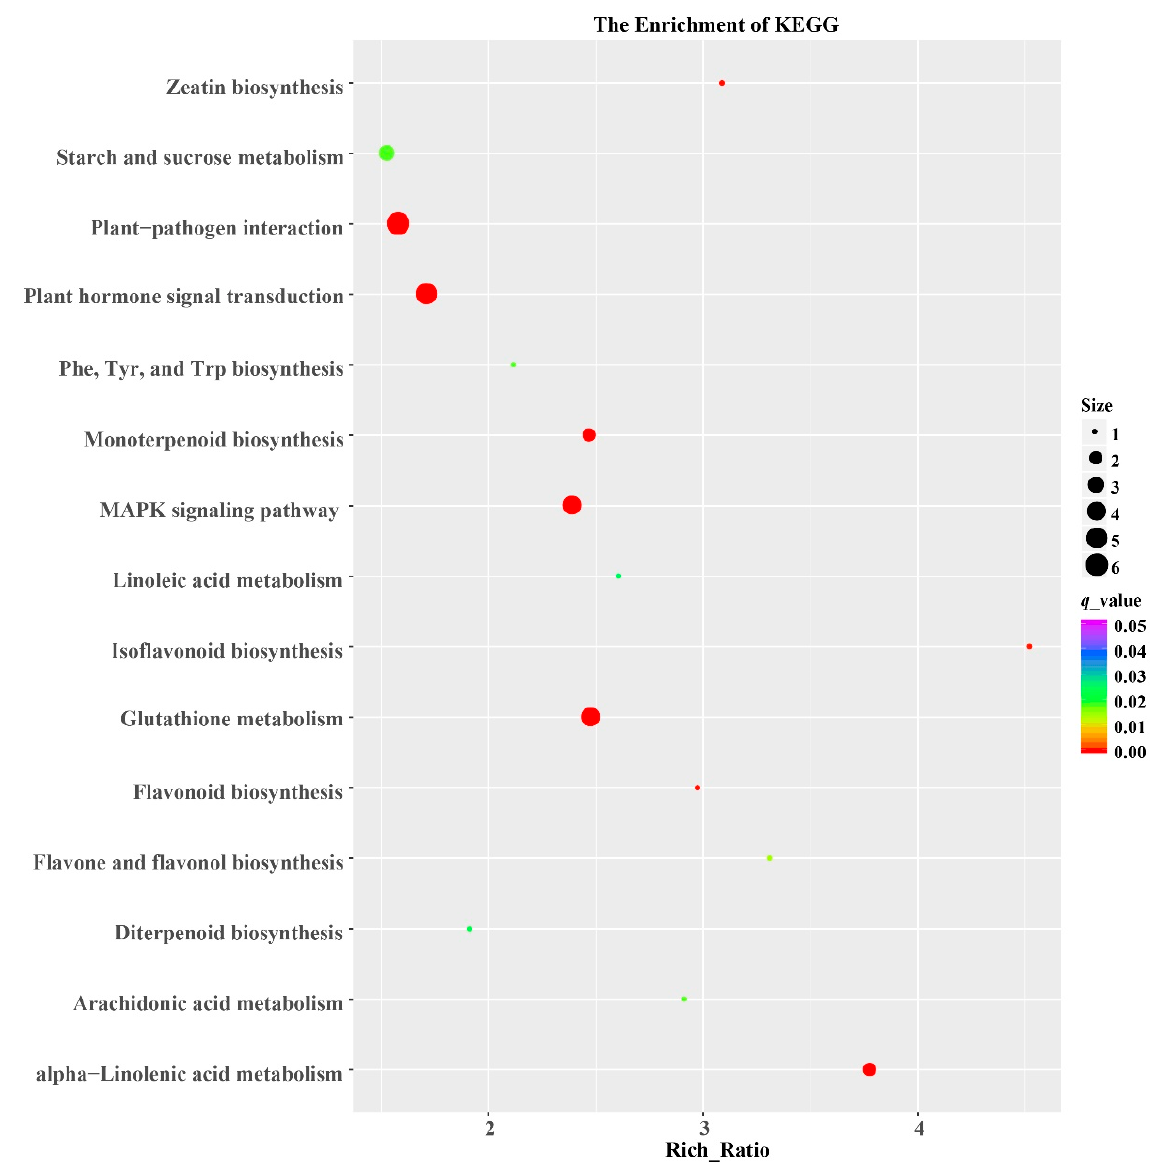
Figure 5. Top fifteen KEGG pathways for high and low ‐ NUE wheat NILs grown under normal N conditions. The x ‐ axis indicates the rich ratio, the y ‐ axis represents the name of the KEGG pathway. The sizes of bubbles represent the number of DEGs in the corresponding pathway, and the dot color indicates the q ‐ value.